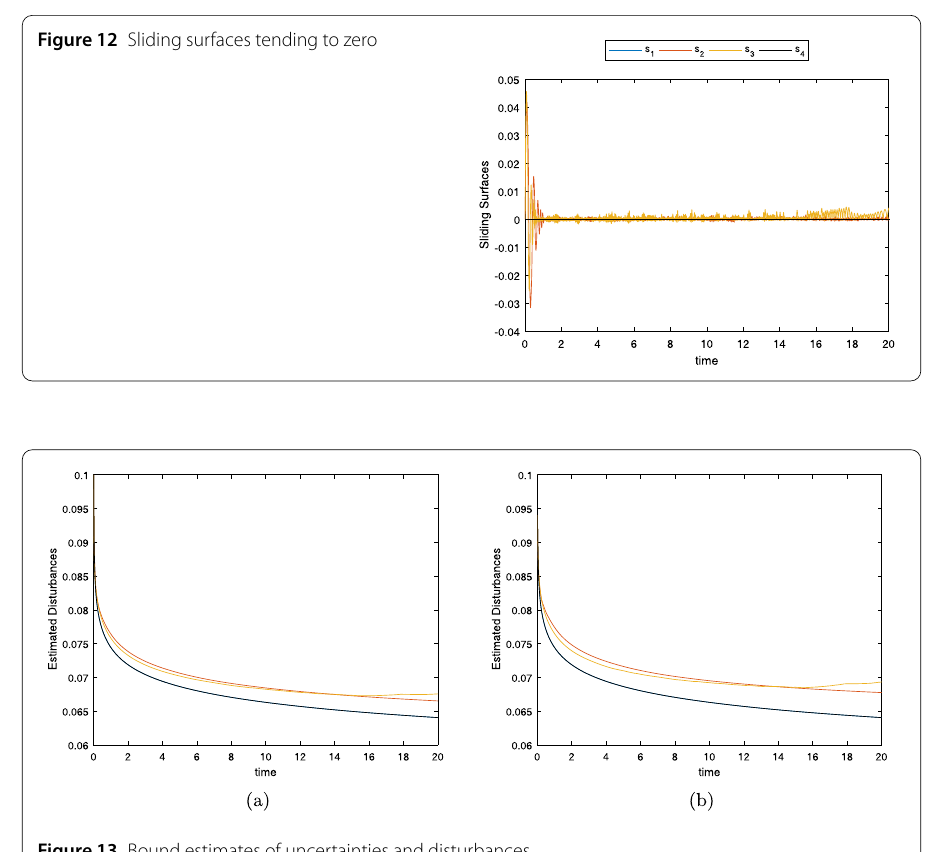
Figure 13 Bound estimates of uncertainties and